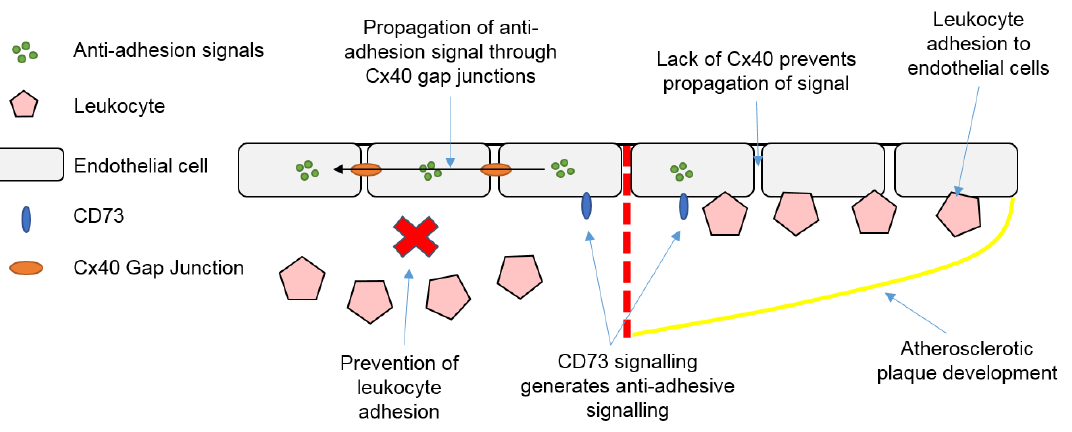
Figure 2. Connexin 40 gap junctions between endothelial cells are atheroprotective through preventing leukocyte adhesion. Yellow line = atherosclerotic plaque border. Abbreviations: Cx =